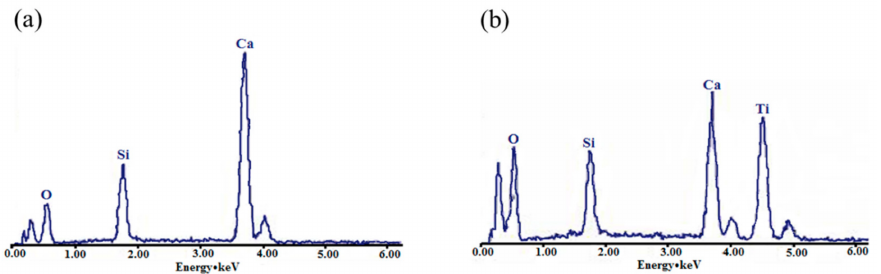
Figure 3. The element energy spectrum (EDS) of wollastonite and TiO 2 -coated wollastonite composite pigments ( a ) wollastonite; ( b ) TiO 2 -coated wollastonite composite pigments.